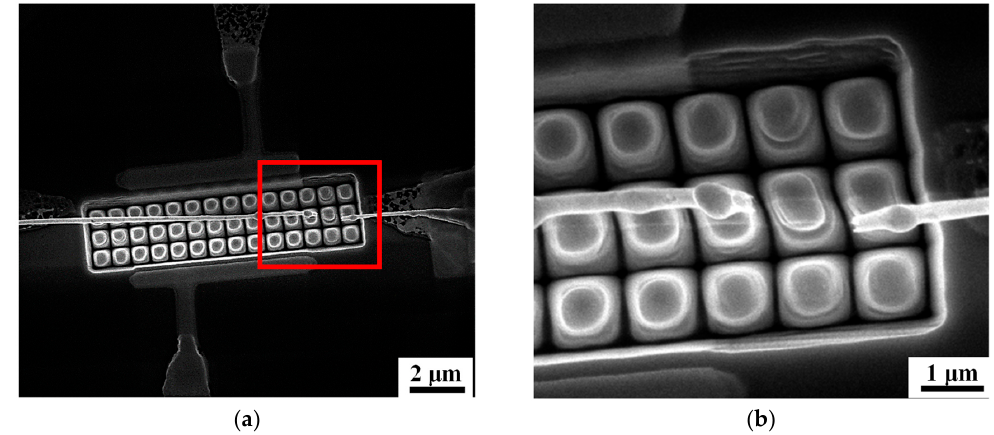
Figure 4. SEM images of nanowire failure: ( a ) a broken nanowire after gas discharge in NO 2 /N 2 ; ( b